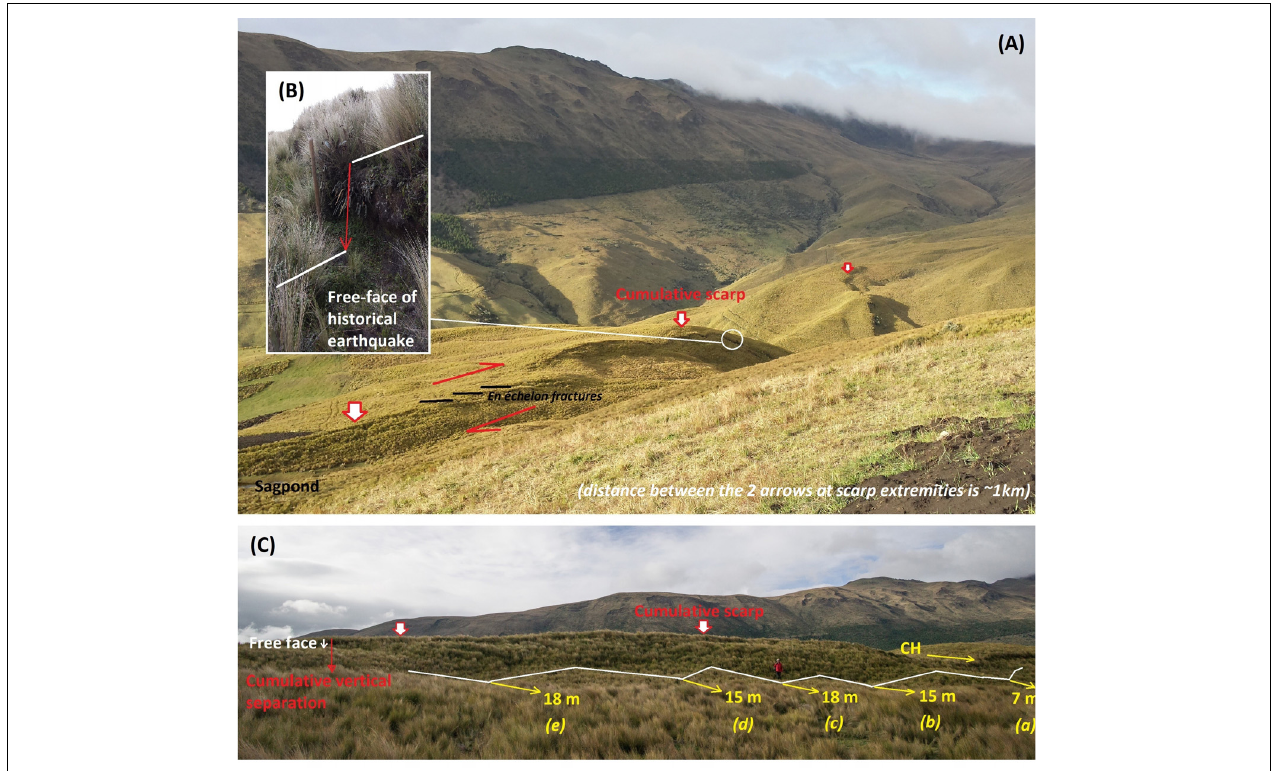
FIGURE 6 | Field observations along the main DEM lineament, which clearly corresponds to a cumulative uphill-facing counter scarp that offsets morphological features (A) . A focus on the top of this scarp allows to document a fresh free face scarp (B) that is proposed to correspond to the last historical earthquake of the area (M7.6 1797 Riobamba earthquake); en echelon open fractures could be related to this event as well. Picture (C) nicely illustrates the successive right-lateral offsets of a small incision feature at the base of the cumulative scarp; those offsets seem too high to be associated with one single event and this could reveal the discontinuous incision of the feature as